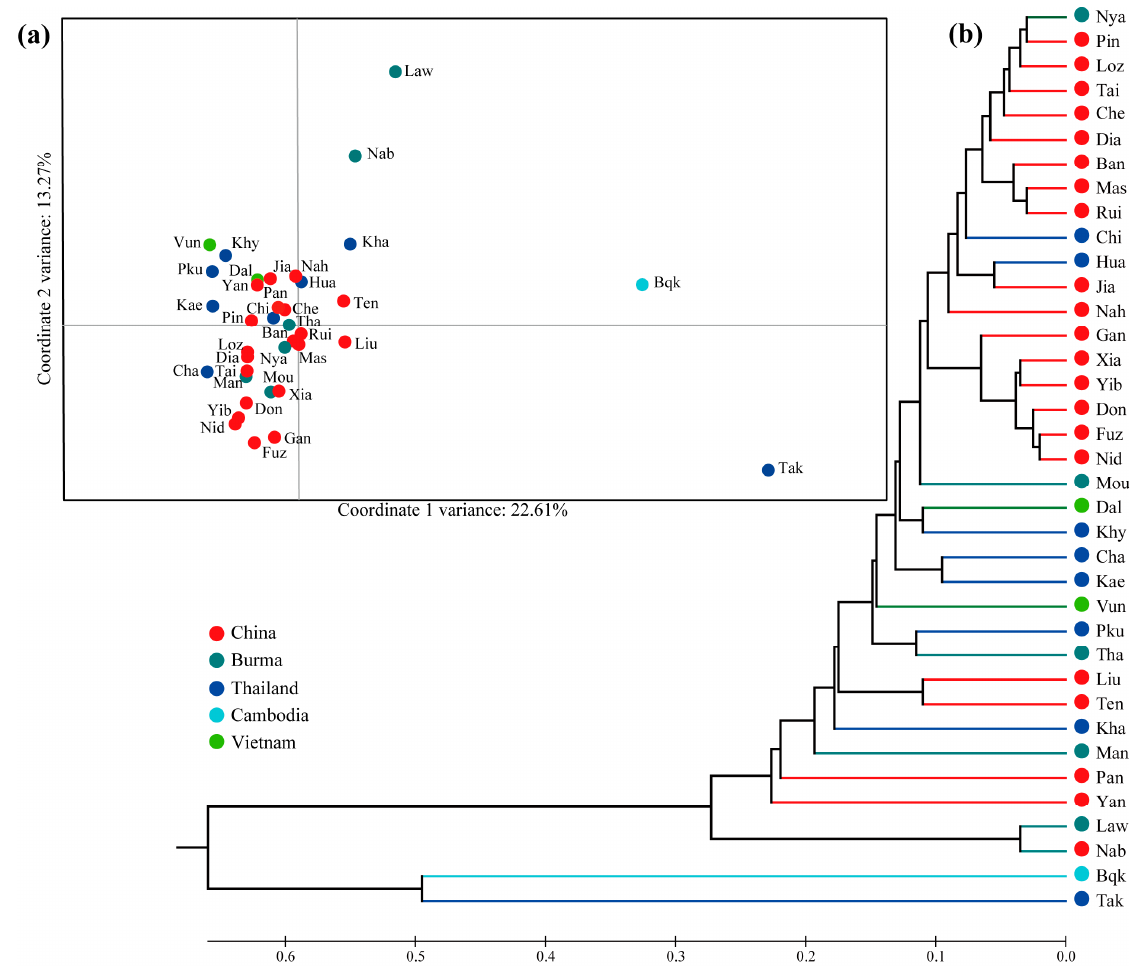
Figure 4. The interpopulation genetic affinity of 37 F. altssima populations based on microsatellite data: ( a ) two-dimensional scatter diagram based on principal coordinate analysis; ( b ) dendrogram based on the unweighted pair-group method with arithmetic average (UPGMA). The populations collected from different countries are marked in different colours. Table 3. Bottleneck test of F. altissima populations with more than ten individual